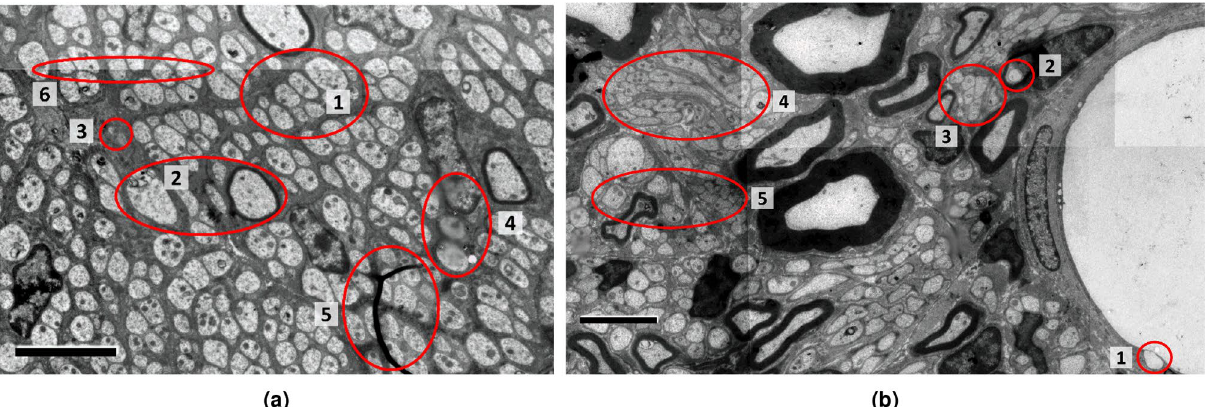
Figure 1. Variability of unmyelinated fibers (UMFs). ( a ) UMFs of different size ( 1 ), myelinated fibers with similar size and shape ( 2 ), fascicle texture mimicking UMFs ( 3 ), imaging artifacts ( 4 , 5 ) and different contrast between tiles ( 6 ). ( b ) Vescicles in the blood vessel ( 1 ) and in a myelinated fiber ( 2 ) mimicking UMFs, clumped UMFs ( 3 ) and UMFs with different shape ( 4 ) or contrast ( 5 ). Scale bars: 2 µ m.